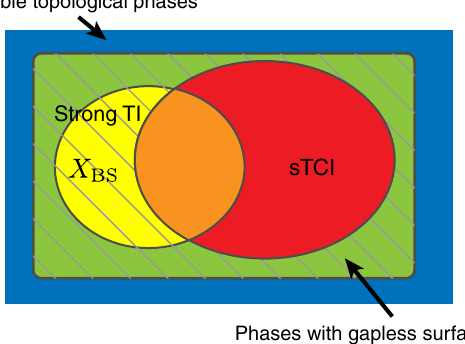
FIG. 9. Hierarchy of crystalline topological insulators with time-reversal symmetry and strong spin-orbit coupling (class AII) in 3D. All nontrivial entries in the symmetry indicator X are BS compatible with gapped topological band structures with gapless surface states on suitably chosen sample geometries. Excluding the strong TIs from the X -nontrivial phases, we found that all BS the remaining phases are anomalous surface topological crystal- line insulators (sTCIs), defined as nontrivial insulators with anomalous surface states, but they can be trivialized upon the breaking of some crystalline symmetries. Note that sTCIs include all gapped topological phases with gapless surface states but are not strong TIs (hatched region). These also include phases not diagnosed by X ; i.e., the topological nature is not exposed by BS the symmetry eigenvalues in the